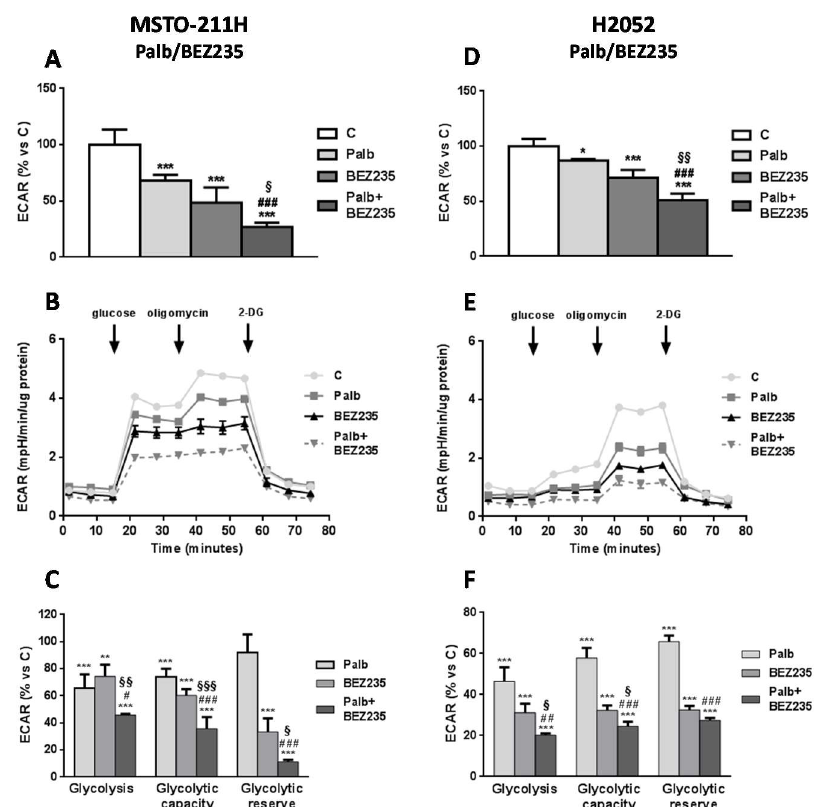
Figure 3. The combined treatment of palbociclib with BEZ235 impairs the glycolytic activity of MSTO-211H and H2052 MPM cells. ( A , D ) The glycolytic activity was measured using the Agilent SeaHorse XP analyzer after 24 h of treatment with palbociclib 1 µ M, BEZ235 40 nM, or the combination of palbociclib with BEZ235. ECAR data are shown as mpH / min normalized to proteins and represent the mean ± SD of n = 4 independent measurements under normal cell culture conditions. ( B , E ) Glycolytic profiles were obtained using the Agilent SeaHorse Glycolysis Stress Test. MSTO-211H and H2052 cells were treated as described above. The ECAR was measured under glucose starvation and after the sequential addiction of glucose (substrate for glycolysis), oligomycin (added to maximize the glycolytic flux of the cell) and 2-DG (added to shut down the glycolytic process). The ECAR profiles are representative of two di ff erent experiments that yielded similar results. ( C , F ) The parameters of glycolysis, glycolytic capacity, and glycolytic reserve were calculated as percent versus control cells. The data are expressed as the media ± SD of at least three independent measurements. * p <